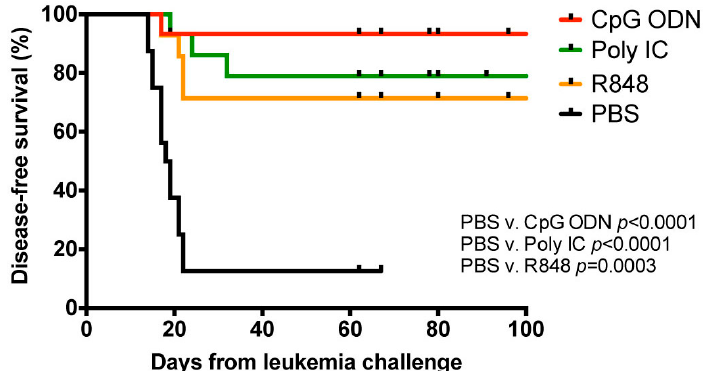
shown are from one independent experiment; n = 4 mice per group. n.s = not significant.